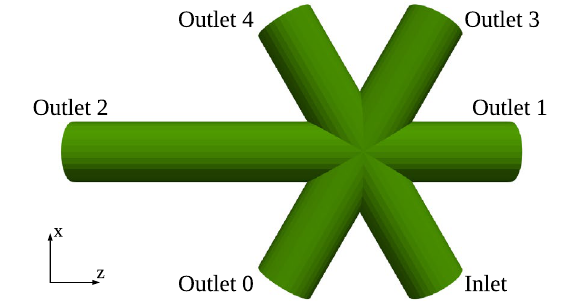
Figure 1. The five-outlets model in the lateral view. It is composed by joining five identical short pipes and a longer pipe all converging on a single point. The longer pipe is twice the length of a short